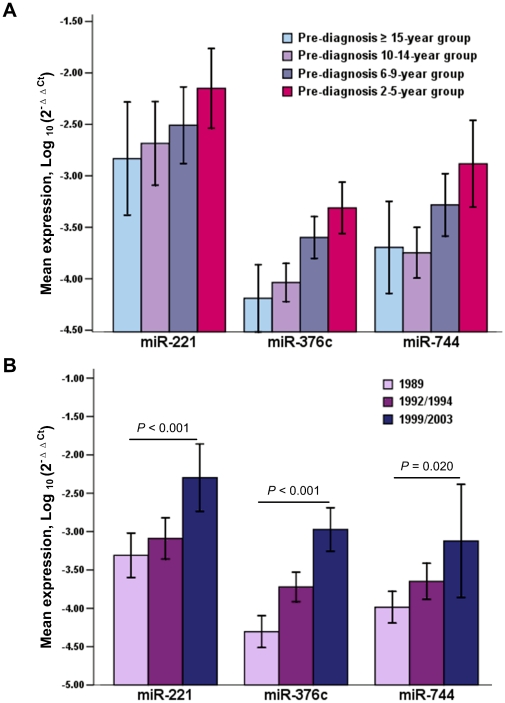
The temporal trends of serum miR-221, miR-376c and miR-744 levels during GC development.(A) In the retrospective study, miRNA levels were examined in the pre-diagnosis serum samples of 58 cases that were classified into four groups according to the time interval between blood collection and GC diagnosis. (B) The trend tests of miRNA levels over time were performed in 20 GC cases who provided three serum samples at three time points of the follow-up (in the years of 1989, 1992 and 1999; or in the years of 1989, 1994 and 2003). The mean values of relative miRNA levels that were normalized to the spiked-in cel-miR-39 and transformed on a logarithmic scale were shown with the error bar representing 95% CI (A–B).